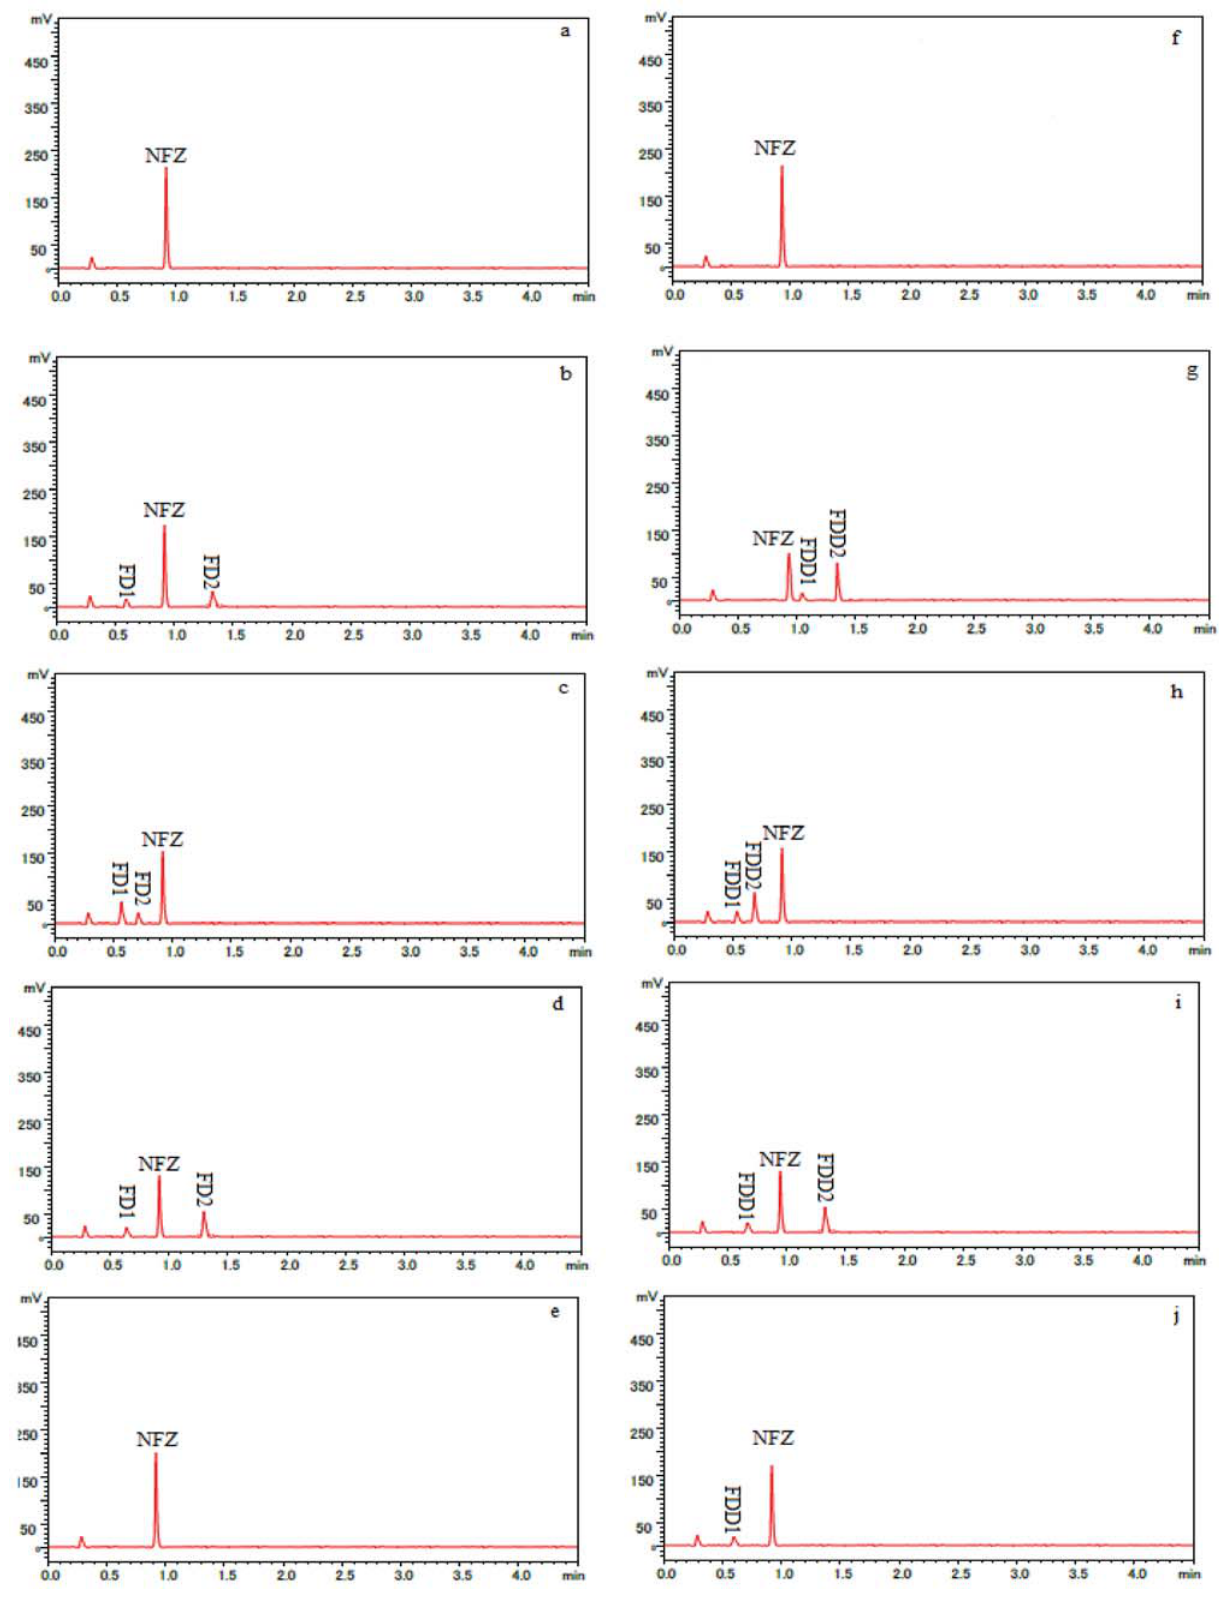
Figure 3. Typical UHPLC chromatograms of pure bulk sample of NFZ (50 μg mL –1 ) under stress conditions. Mild stress conditions: (a) acidic (b) basic (c) oxidative (d) thermal (e) photolytic. Drastic stress conditions: (f) acidic (g) basic (h) oxidative (i) thermal (j) Ali et al.: Stability Indicating UHPLC-PDA Assay ...